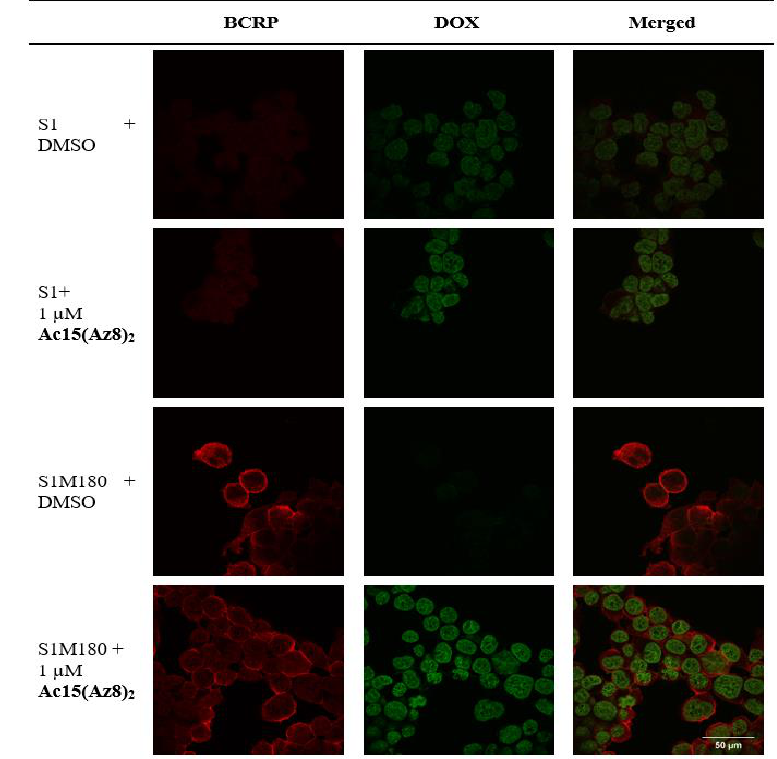
Figure 3. Localization of BCRP and the intracellular DOX retention in S1 and S1M180 cells were studied by confocal microscopy. After 24-h incubation with DOX in the presence of DMSO or Ac15(Az8) 2 . S1 or S1M180 cells were washed and stained with anti-BCRP antibody BXP-21 (shown as red). DOX fluorescence was monitored at 488 nm excitation and 590 nm for emission (shown as green).